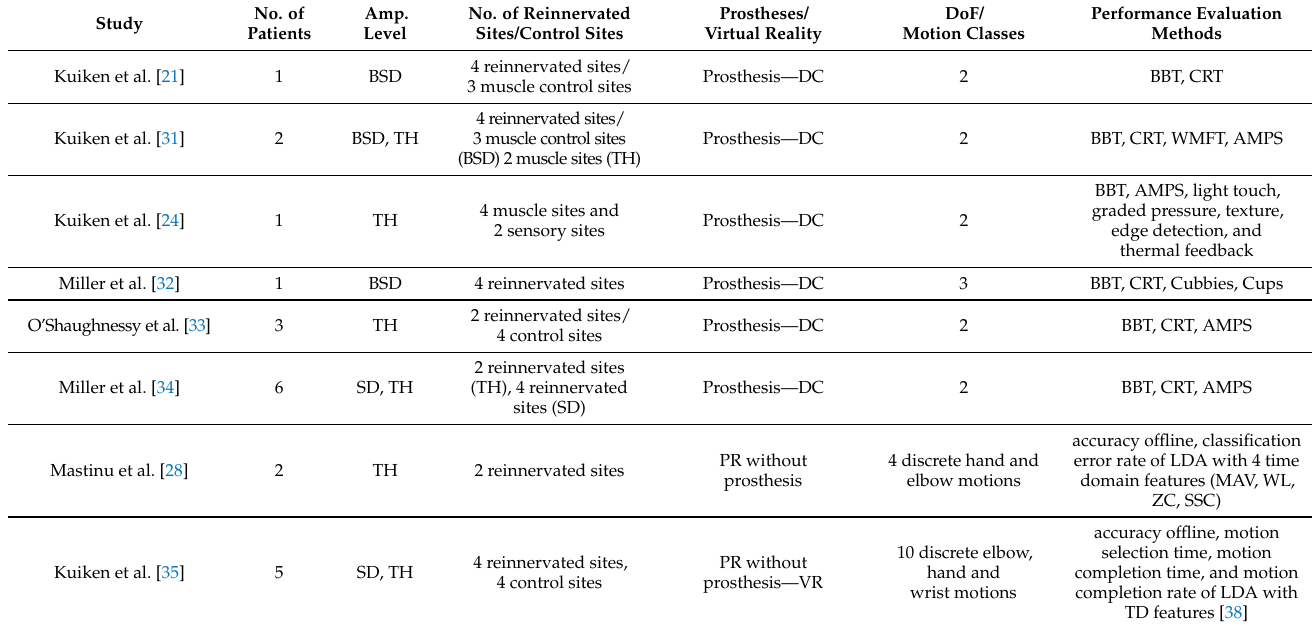
Figure 4. Flow diagram of the search and inclusion process. Table 1. Summary of the reported